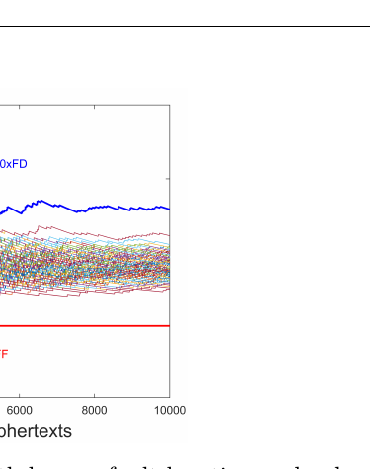
Figure 3: Exemplary PFA on AES with known fault location and